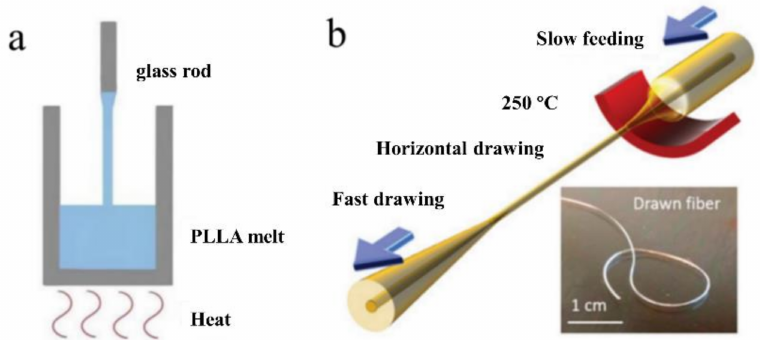
Figure 4. ( a ) A schematic of the simplified thermal drawing process of the PLLA-based optical fiber. (Adapted from ref. [45]). ( b ) A schematic of the horizontal thermal drawing process of TPE-based fiber. (Reprinted with permission from ref.